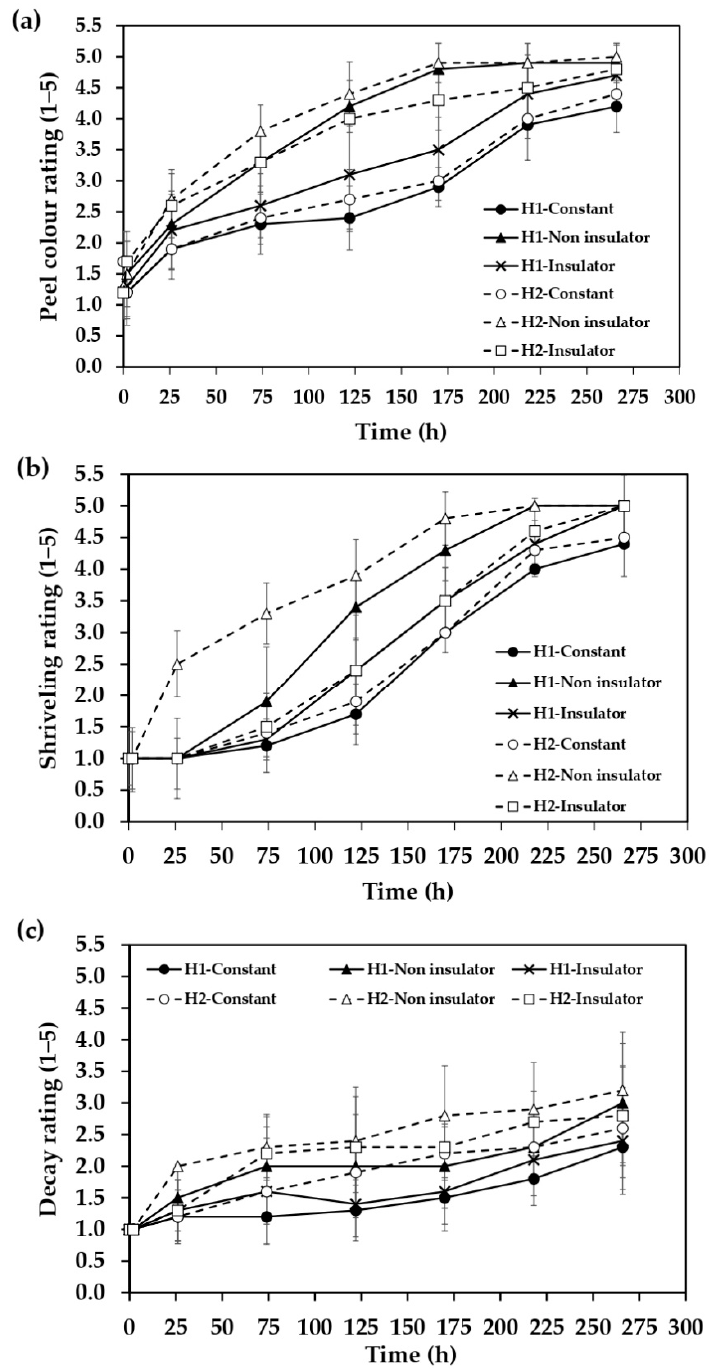
Figure 9. ( a ) Peel colour, ( b ) shrivelling, and ( c ) decay of mango fruits (‘Nam Dok Mai Si thong’) under constant, non-insulated, and insulated conditions during simulated handling at the tarmac. After simulated handling at the tarmac, mango fruits from the first and second harvest were transferred to 20 ◦ C for 266 h. H1, first harvest; H2, second harvest. Vertical bars on the graph indicate S.D. ( n = 10).